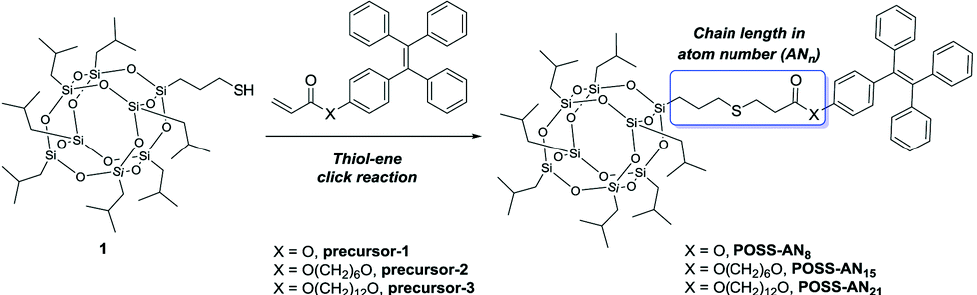
Figure 6. Synthesis of POSS-AN 8 , POSS-AN 15 and POSS-AN 21 [46] . Copyright 2016, Royal Society of Chemistry.